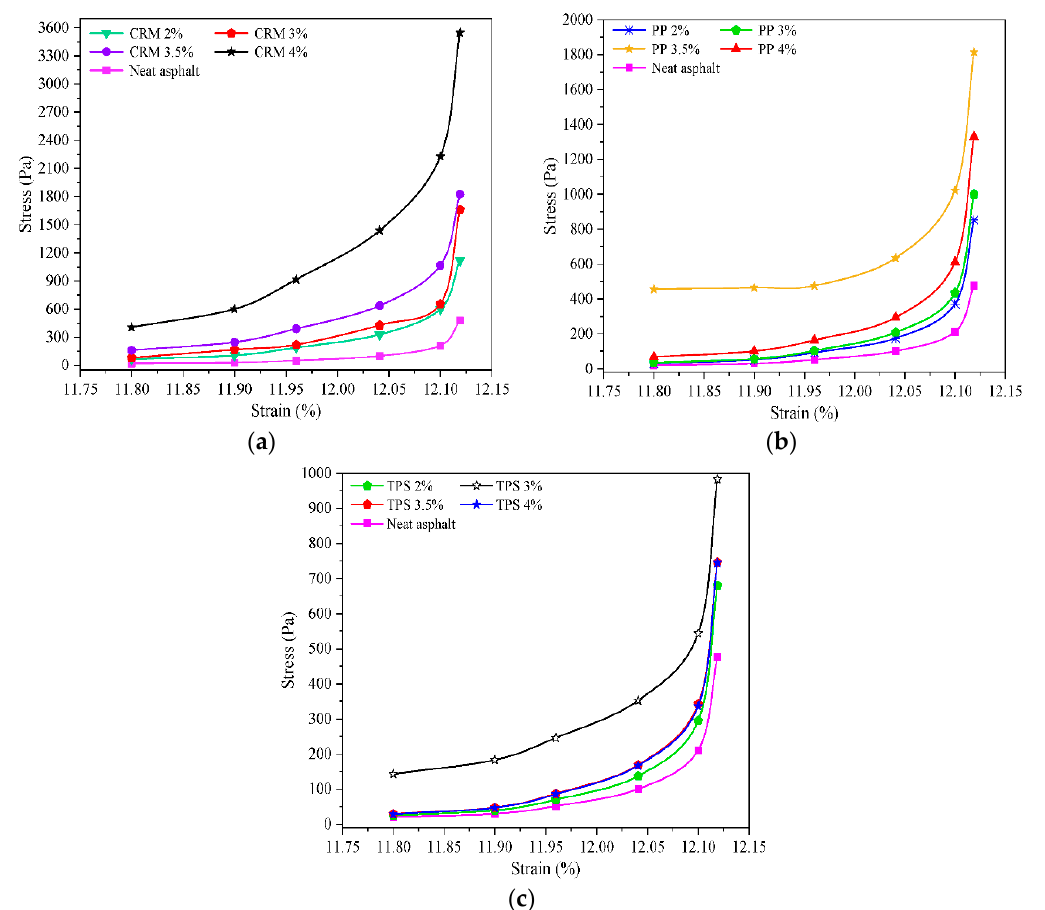
Figure 8. The stress-strain relationship at medium- and high-temperatures: ( a ) CRM; ( b ) PP; and ( c ) TPS.